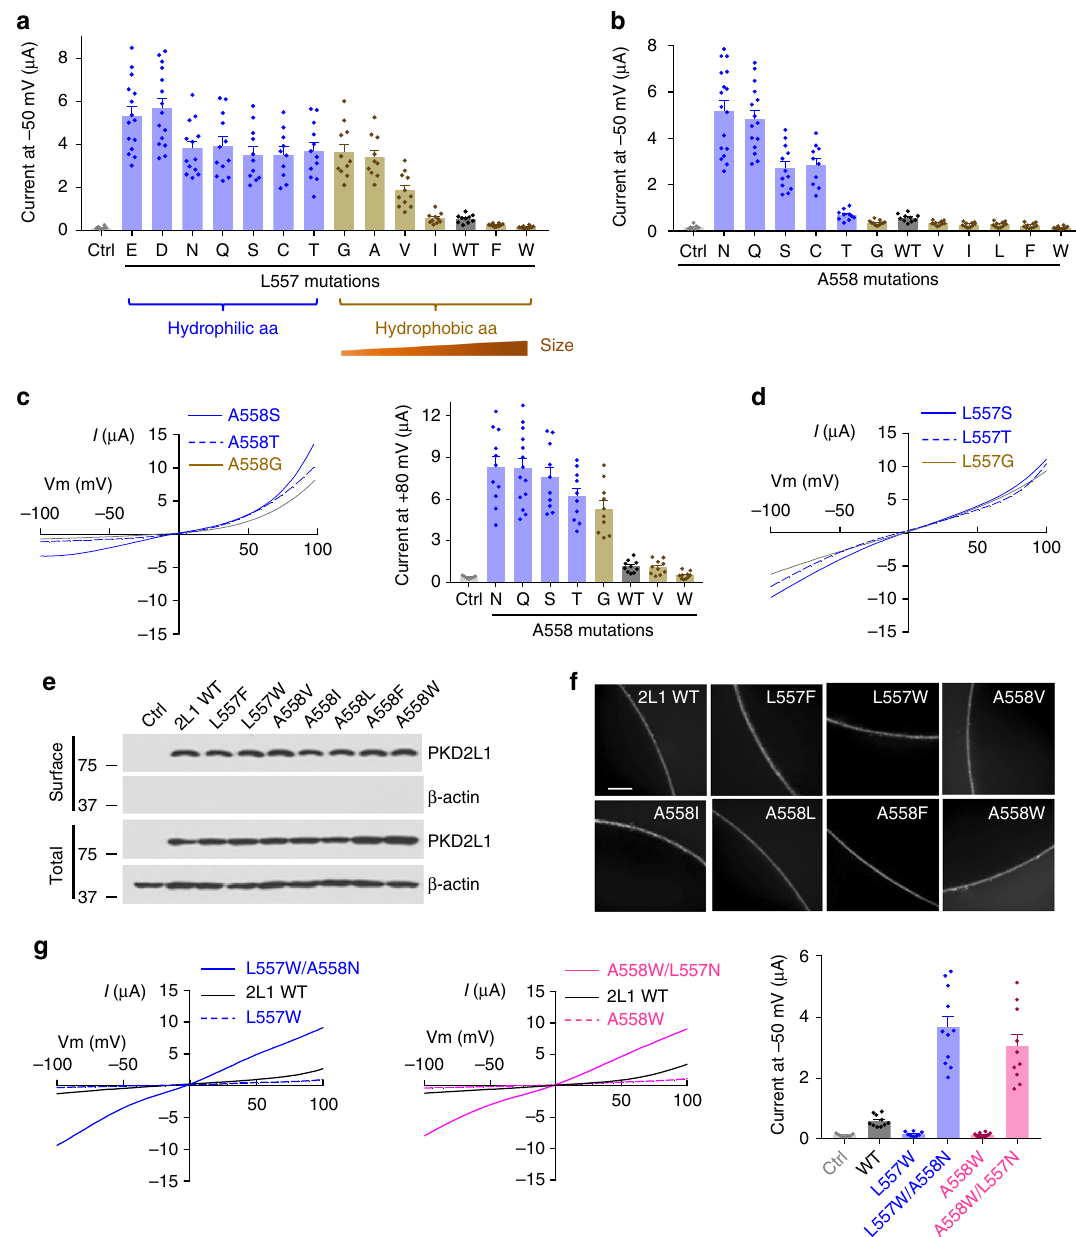
Fig. 2 Characterization of mutants at PKD2L1 sites L557 and A558. a L557 was replaced with different aa, as indicated. Shown are averaged currents obtained under the same experimental conditions as in Fig. 1b ( n = 10 – 15 oocytes from 3 batches). Data are presented as mean ± SEM. b A558 was replaced with different aa, as indicated, and averaged currents were obtained as in Fig. 1b ( n = 10 – 17 oocytes from 3 batches). Data are presented as mean ± SEM. c Left panel, representative I – V curves for three indicated A558 mutants generated under the same experimental condition as in Fig. 1d. Right panel, averaged outward currents at + 80 mV for indicated A558 mutants ( n = 10 – 14). Data are presented as mean ± SEM. d Representative I – V curves for three indicated L557 mutants obtained as in Fig. 1d. e Western blot of surface biotinylated and total protein of PKD2L1 WT or indicated mutants. f Whole-mount immuno fl uorescence showing the oocyte surface expression of PKD2L1 WT or mutants from e . Scale bar, 50 μ m. g L557 and A558 were replaced with W or N. Left panel, representative I – V curves of PKD2L1 WT or indicated mutants obtained as in Fig. 1d. Right panel, averaged current at − 50 mV for PKD2L1 WT or indicated mutants ( n = 8 – 11). Data are presented as mean ±